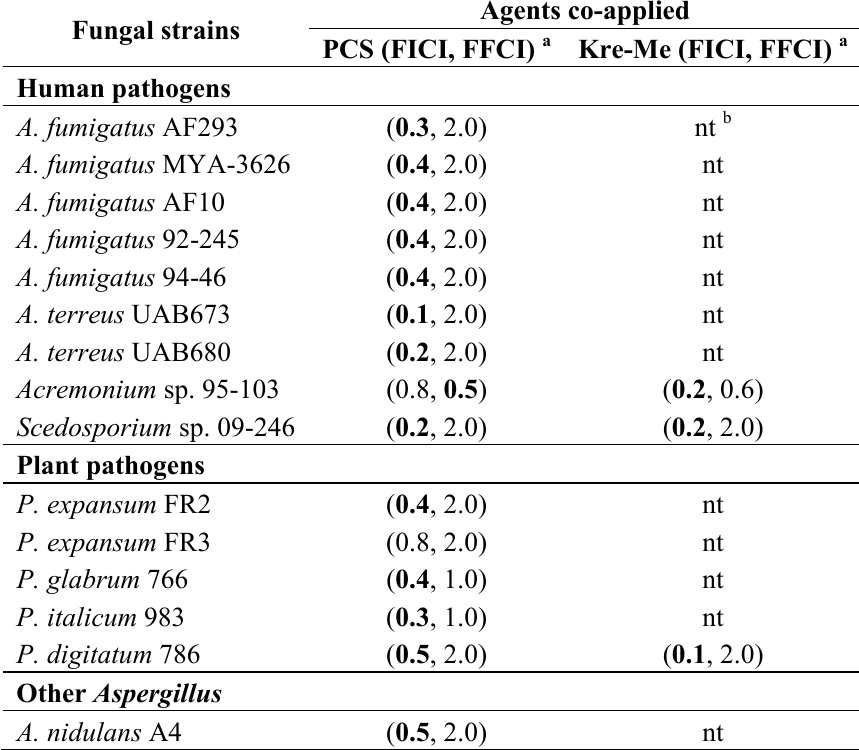
Table 5. Summary of responses of filamentous fungi to the co-application of KA with PCS and/or Kre-Me (CLSI-based microdilution